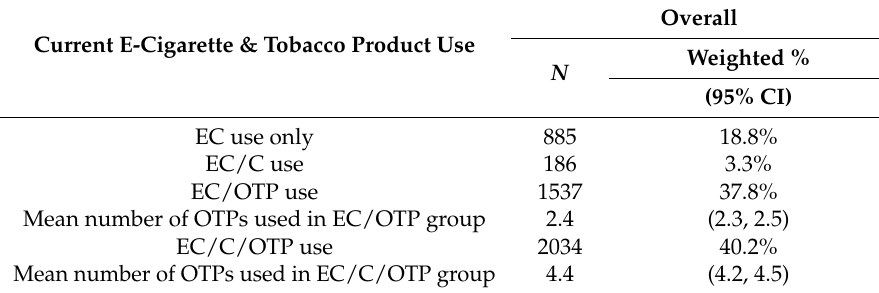
Table 1. Current tobacco product use among youth current e-cigarette users in the Florida, Florida Youth Tobacco Survey,